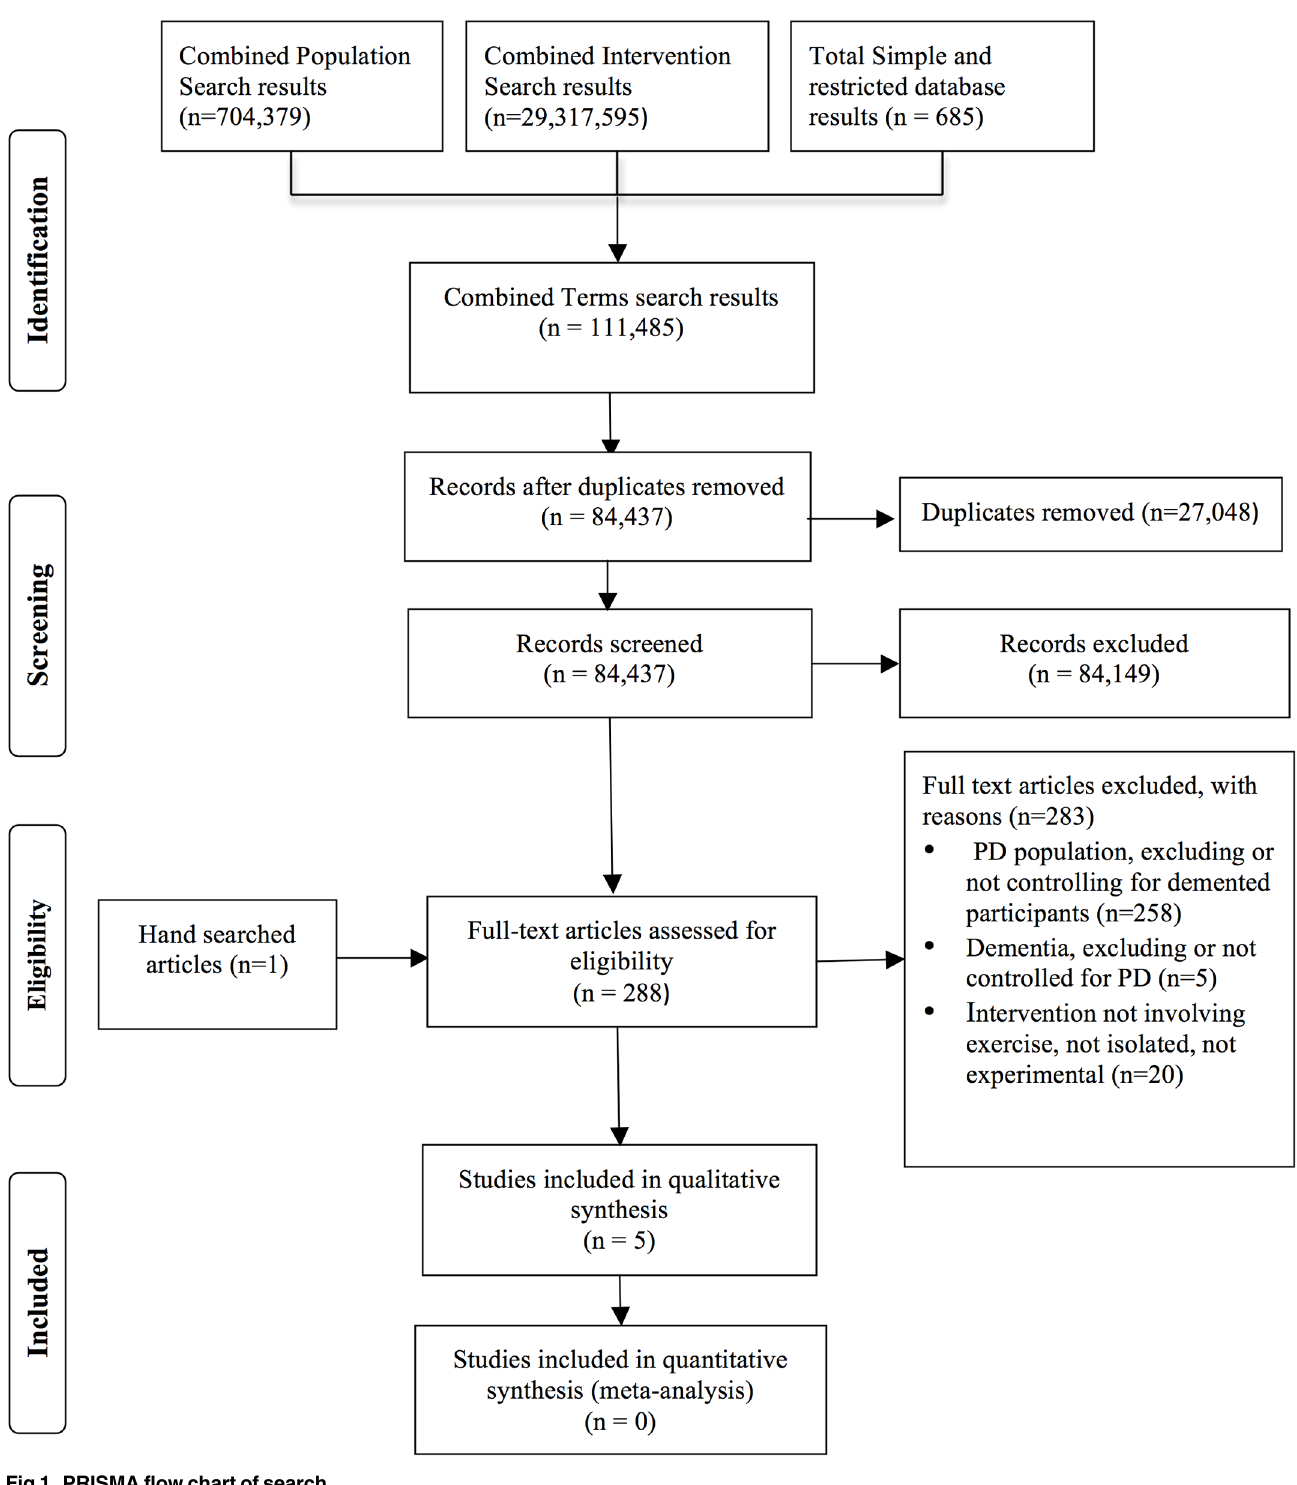
Fig 1. PRISMA flow chart of search.